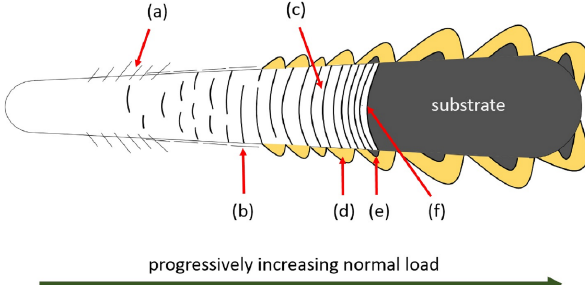
Figure 9: Schematic representation of the scratch channel obtained during scratch tests of hard ceramic coatings: (a) forward chevron tensile cracks, (b) lateral cracks, (c) arc tensile cracks, (d) coating chipping, (e) thin film spalling, (f) coating break-through (based on [59,